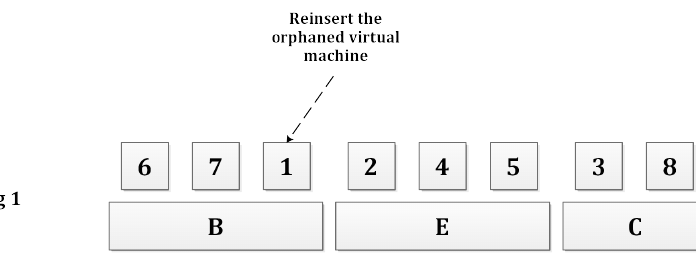
Figure 8. Reinsert the orphaned virtual